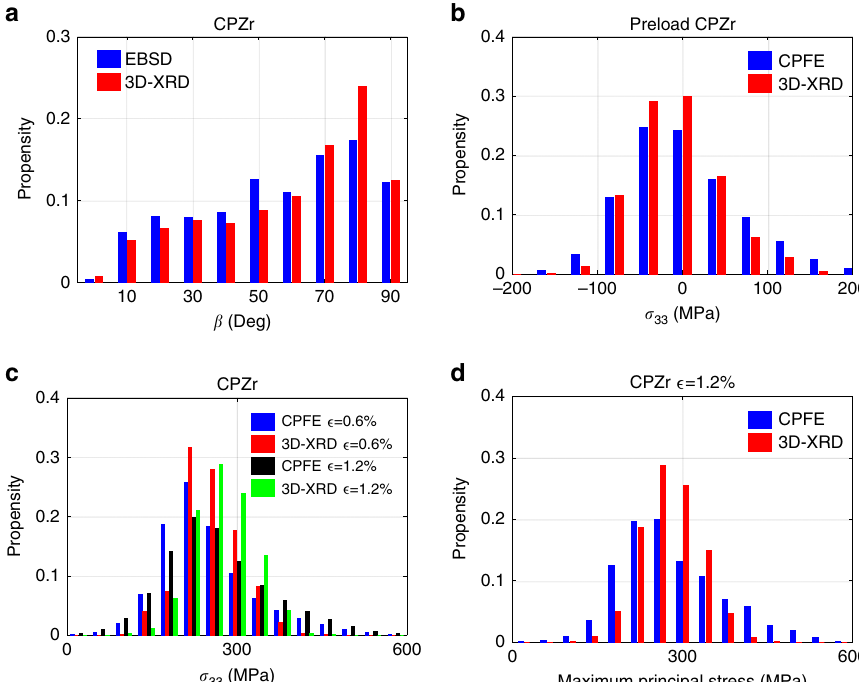
Fig. 3 General trends. a The propensity of misorientation ( β ) between basal plane normal and the loading direction measured by 3D-XRD and EBSD. Comparison between 3D-XRD measured and CPFE-NSH simulated values for σ 33 ( b ) at the preload and ( c ) applied strain of 0.6 and 1.2%. d Measured and calculated maximum principal